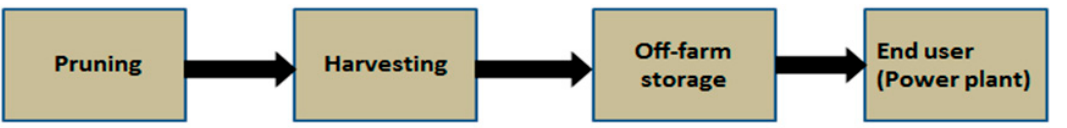
Figure 1. Typical pruning biomass logistics chain (source: authors own illustration). Table 1. Major characteristics of the biomass supply chain and the related impacts on biomass-energy systems.